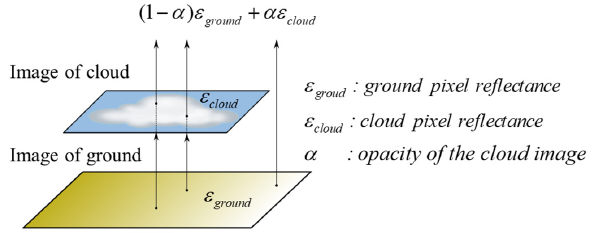
Figure 2. RS image imaging process schematic diagram. α is the opacity of the foreground, and the foreground and background pixel reflection signals are ε cloud and ε ground ,